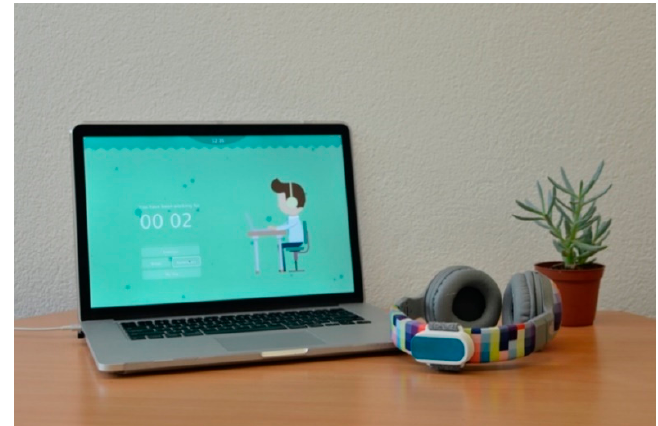
Figure 1. Project result, Neckio, a smart system comprises a desktop application and a headphone-attached tracking band.